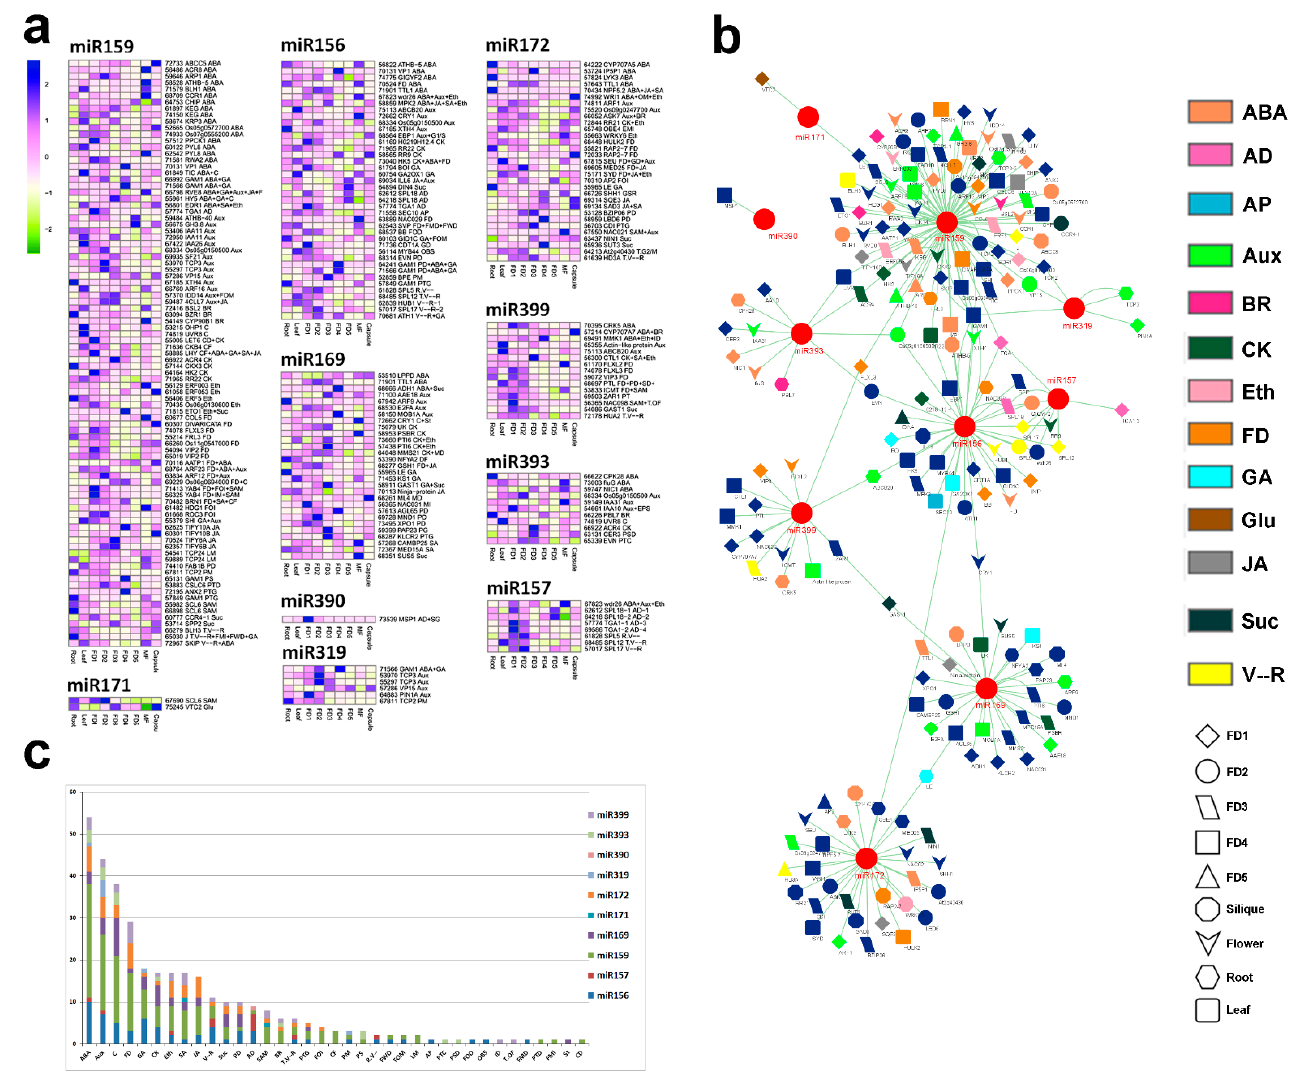
Figure 3. Major miRNA families for flower regulation. ( a ) heatmap of genes targeted by each miRNA family; ( b ) gene distribution for each miRNA family, color bands show biological process enrichment of target genes, node shapes show the stage-specific high expression of target genes; ( c ) relative abundance of biological process shown by all gene targets of miRNA families (ABA: Abscisic Acid; Aux: Auxin; C: Carpel; FD: Flower Development; GA: Gibberellic acid; CK: Cytokinin; Eth: Ethylene; SA: Salicylic Acid; JA: Jasmonic Acid; V—R: Vegetative to Reproductive phase change; Suc: Sucrose; PD: Pollen Development; AD: Anther Development; SAM: Shoot Apical Meristem; BR: Brassinosteroid; T.V--R: Timing of Vegetative to Reproductive phase change; PTG: Pollen Tube Growth; FOI: Floral Organ Initiation; CF: Carpel Formation; PM: Pollen Maturity; PS: Pollen Sterility; R.V--: Rate of Vegetative phase change; FWD: Floral Whorl Development; FOM: Floral Organ Maturation; AP: Acceptance of Pollen; PTC: Pollen Tube Reception; PSD: Pollen Sperm Cell Differentiation; FOD: Flower Organ Development; Organ Boundary Specification; ID: Inflorescence Determination; T.OF: Timing of Organ Formation; FMD: Floral Meristem Development; FMI: Floral Meristem Identity; St: Strigolactone; CD: Carpel Development).